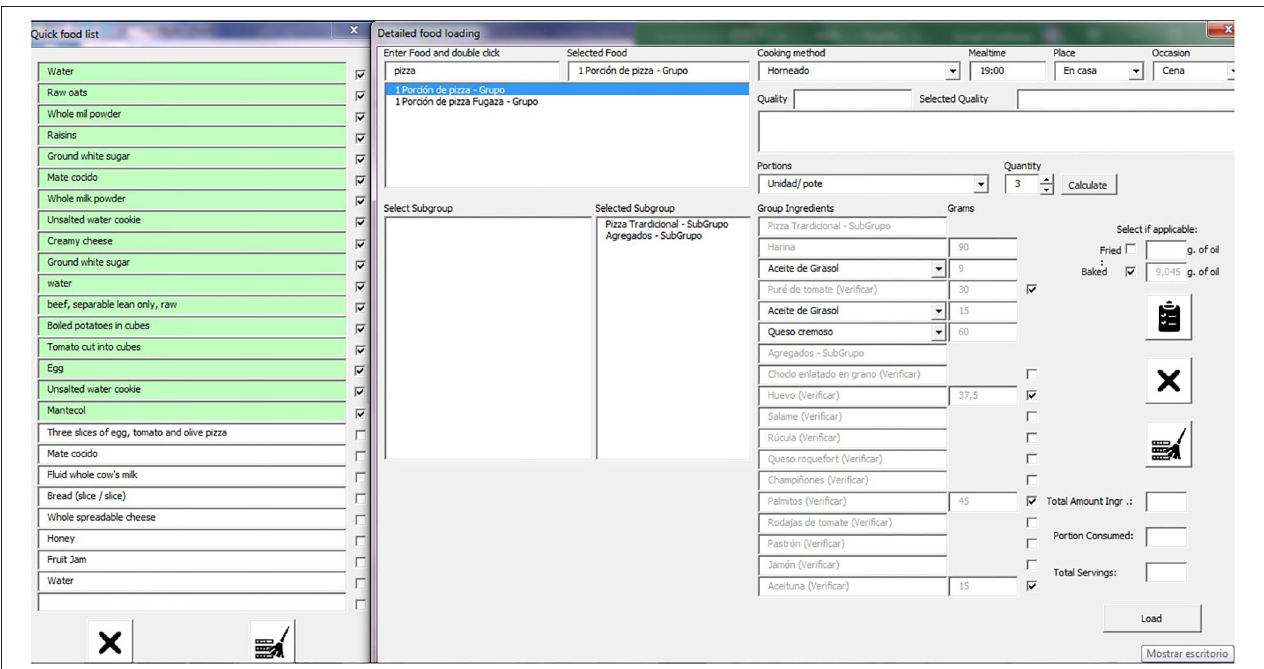
FIGURE 3 | Dietary intake module of the